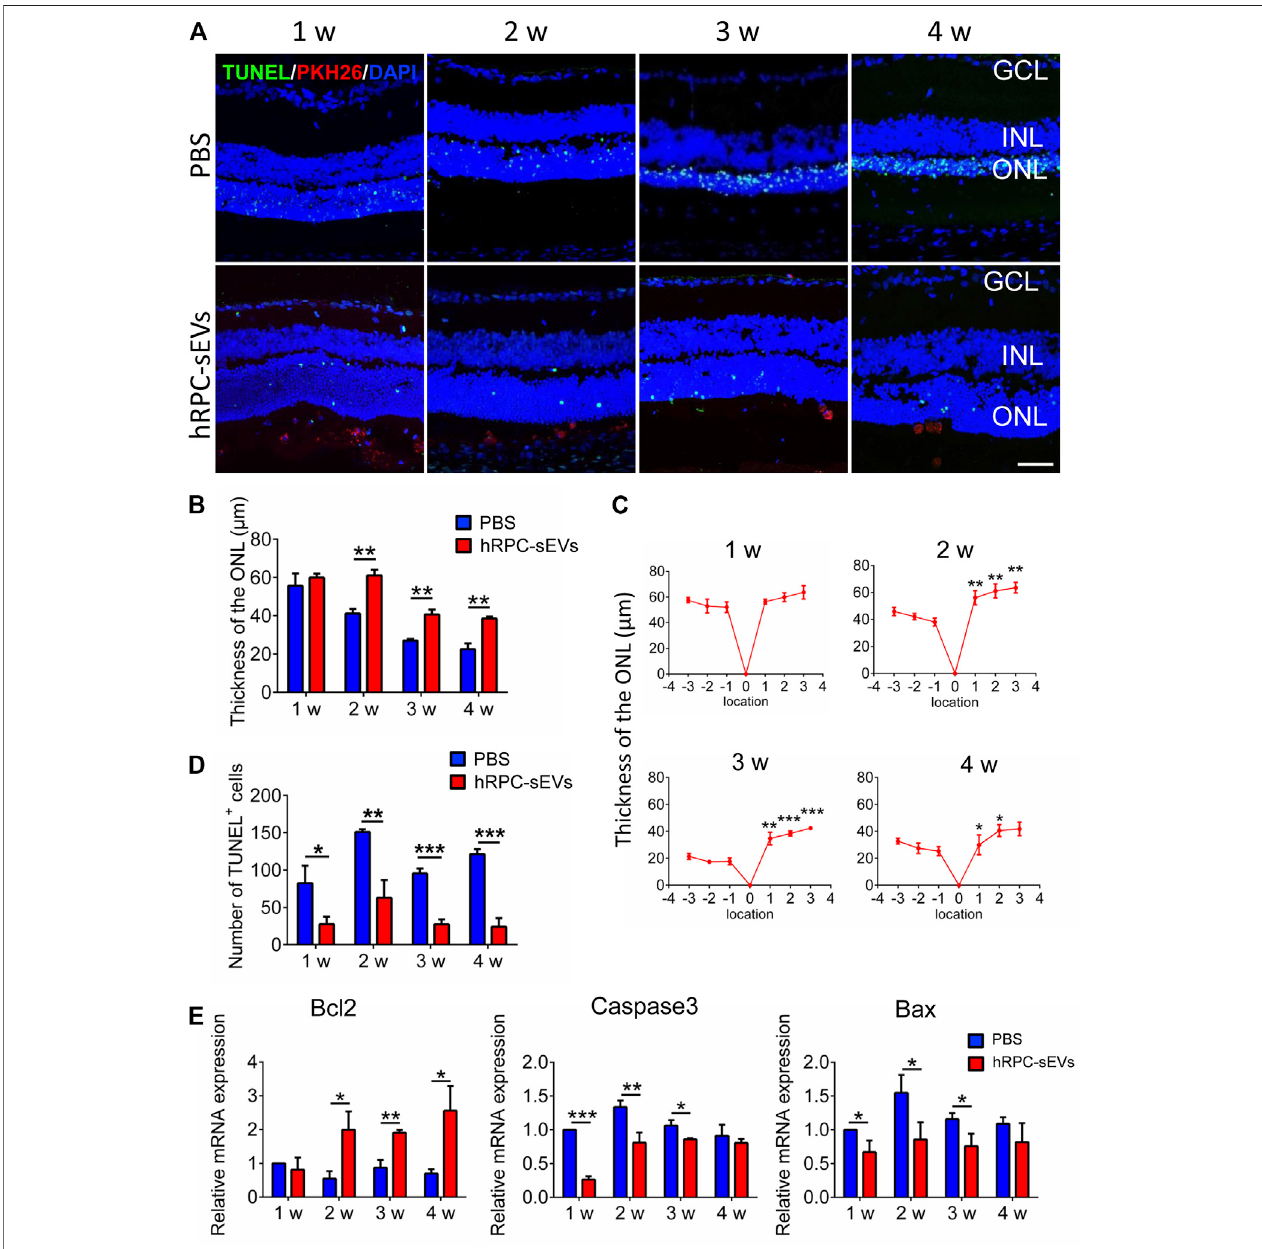
FIGURE2| hRPC-sEVsprotect photoreceptors fromapoptosis inRCSrats. (A) Apoptosis detection ofTUNELand DAPIstaininginhRPC-sEV – andPBS-treated RCS retinas at 1 to 4 weeks after injection. hRPC-sEVs are prelabeled with PKH26 (red). Scale bar, 50 μ m. (B) Thickness of the ONL at the injected sites in hRPC-sEV and PBSgroupsat eachtime point.Thethickness ofONLaroundtheinjected areaissigni fi cantlypreservedinthehRPC-sEV group2weeksafterinjectioncompared to thePBSgroup,andthiseffecthasmaintainedto4weeksafterinjection(n (cid:2) 3). (C) ThethicknessofONLiscomparedinhRPC-sEVsatdifferentinjectedbitamporal locations,distancefromopticnervehead(ONH), from1,2,3,and4weeksafter transplantation (n (cid:2) 3).Thethickness oftheONLinthetransplanted area(temporal fi eld) issigni fi cantlypreservedcomparedtothatofthedistalarea(nasal fi eld). (D) ThenumbersofTUNEL-positivecellsintheretinaofRCSratsareanalyzedinhRPC-sEVand PBS groups at each time point (n (cid:2) 3). hRPC-sEV treatment signi fi cantly reduces the number of TUNEL-positive cells around the injected area of eyes in RCS rats. (E) Real-timeqPCRanalysisshowingrelativemRNAexpressionofapoptotic factors Bcl2,Caspase3,andBaxintheretinasofthehRPC-sEVandPBSgroups.hRPC-sEVs signi fi cantly reduce the apoptotic factors Bax and Caspase3 and markedly increase the antiapoptotic factor Bcl2 in the retina compared to the PBS group (n (cid:2) 3). Data are shown as means ± SD. * p < 0.05, ** p < 0.01, and *** p < 0.001.